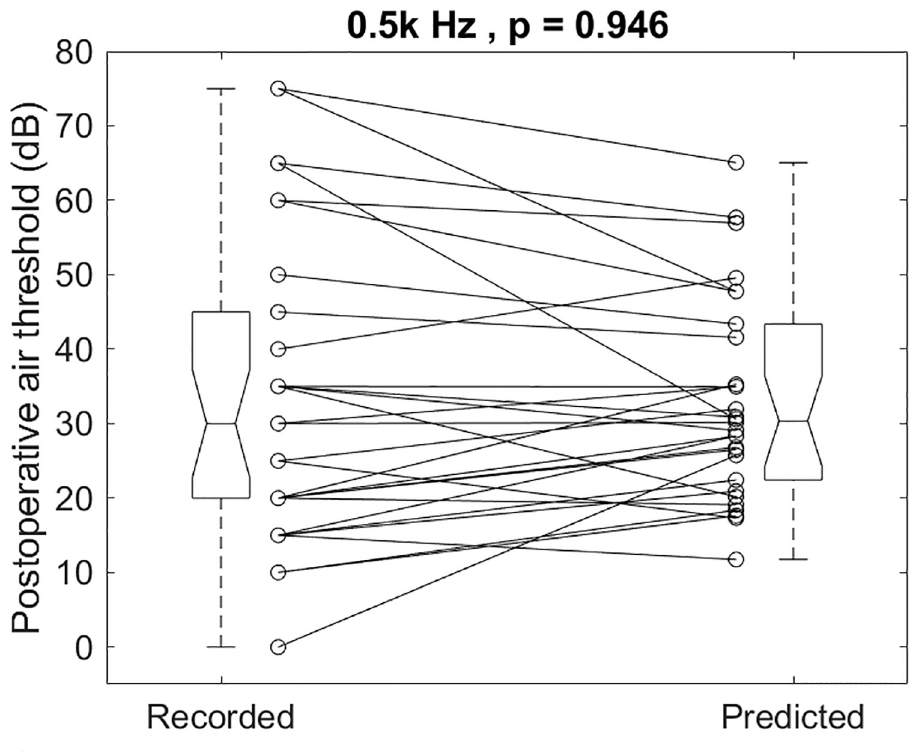
PLOS ONE | https://doi.org/10.1371/journal.pone.0248421 March 11,